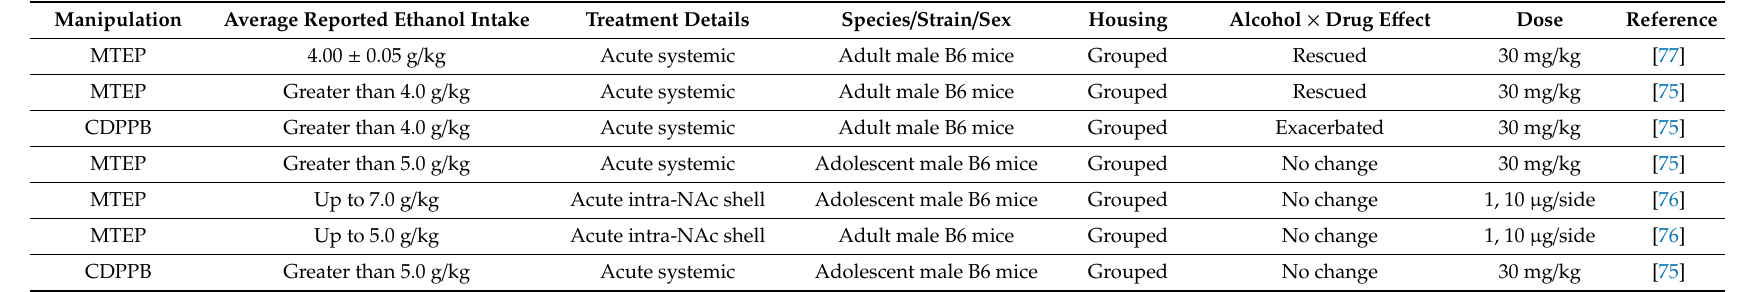
Table 3. Details of the e ff ects of mGlu5 receptor modulation on behavioral despair in the forced swim